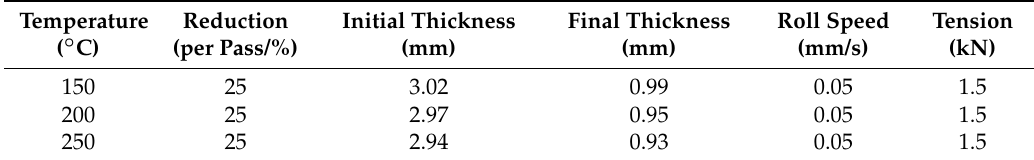
Figure 2. Schematic diagram of the on-line heating rolling machine. Table 2. The detailed parameters of on-line heating rolling